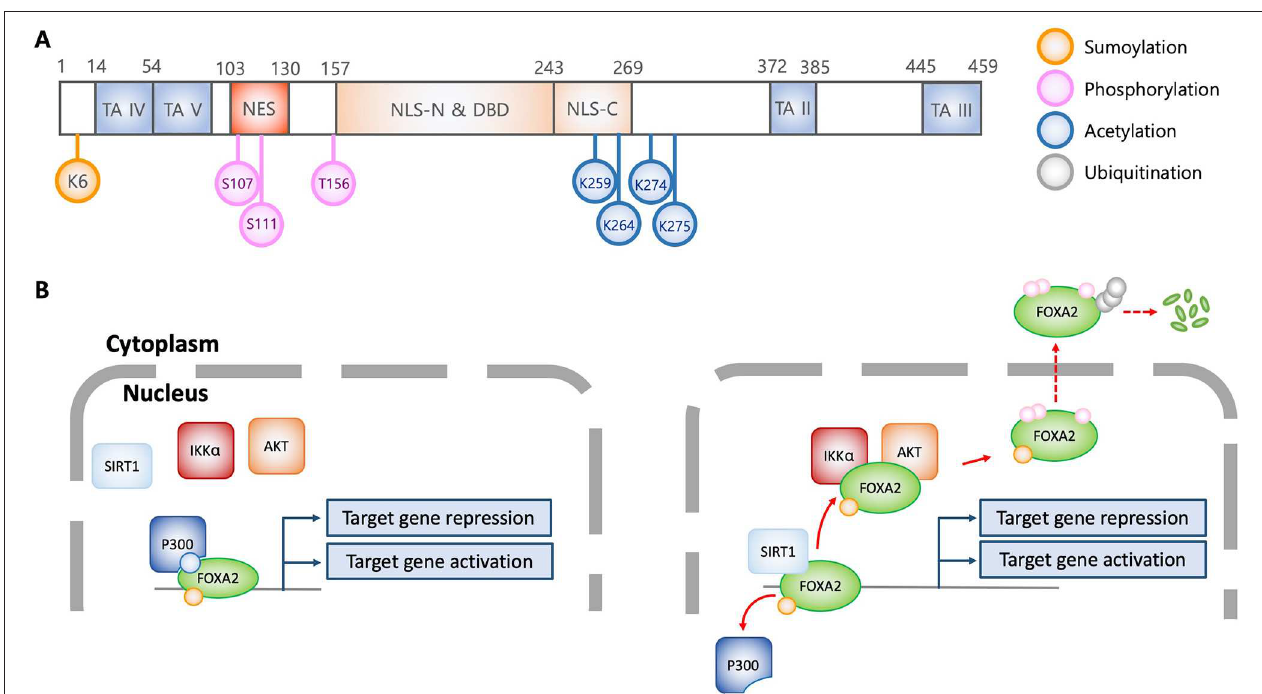
FIGURE 1 | Structural and functional characteristics of FOXA2 in association with posttranslational modification. (A) Schematic diagram of FOXA2 (adapted from J Biol Chem 2009, 284:24816-24; and Mol Cell Biol 1992, 12:3723-3732). Diagram shows functional domains of FOXA2. Colorized circles indicate post-translationally modified amino acid residues which alter FOXA2 functions. TA, transactivation domain; NES, nuclear export signal; NLS, Nuclear localization signal; DBD, DNA binding domain; K, lysine; S, serine; T, threonine. (B) Regulation of transcriptional activity and stability of FOXA2 by posttranslational modifications. Acetylation by P300 allows FOXA2 to be functionally active. In contrast, SIRT1 deacetylates FOXA2, leading to nuclear export via AKT and IKK α -mediated phosphorylation, and subsequently, ubiquitination and degradation. Sumoylation enhances the stability of nuclear FOXA2, which is diminished by ubiquitination, resulting in FOXA2